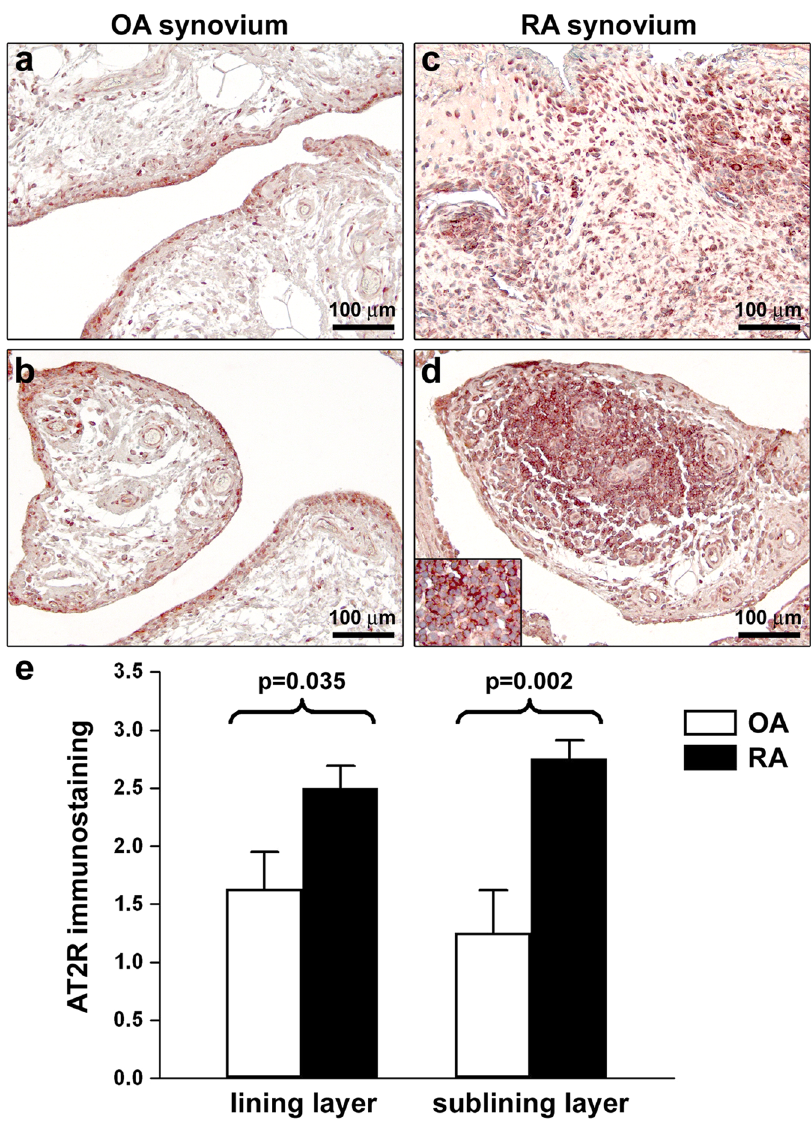
Figure 1. Expression of angiotensin II type 2 receptor (AT2R) in synovial tissue from patients with osteoarthritis (OA) and rheumatoid arthritis (RA). ( a–d ) Representative microphotographs of synovial sections from patients with OA ( a , b ) and patients with RA ( c , d ) immunostained with rabbit polyclonal anti- human AT2R antibody and counterstained with hematoxylin. AT2R immunostaining is stronger in cells of the hyperplastic RA synovial lining compared with OA synovial lining cells, as well as in RA sublining in respect to OA sublining ( a–c ). In RA synovium, ectopic lymphoid structures display a strong immunopositivity for AT2R ( d ). Inset in ( d ): higher magnification view of AT2R-immunopositive lymphocytes within an ectopic lymphoid structure of RA synovium. Scale bars are indicated in each panel. ( e ) Semiquantitative analysis of AT2R immunostaining in synovial lining and sublining layers. Data are mean ± SEM of immunostaining score performed on synovial sections from 8 patients with OA and 8 patients with RA. Student’s t-test was used for statistical analysis; p values are